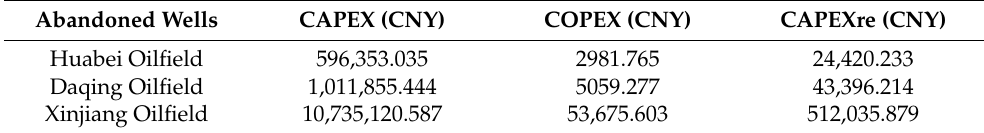
Table 9. Cost parameters of the gravity energy storage systems in the three major oilfields.